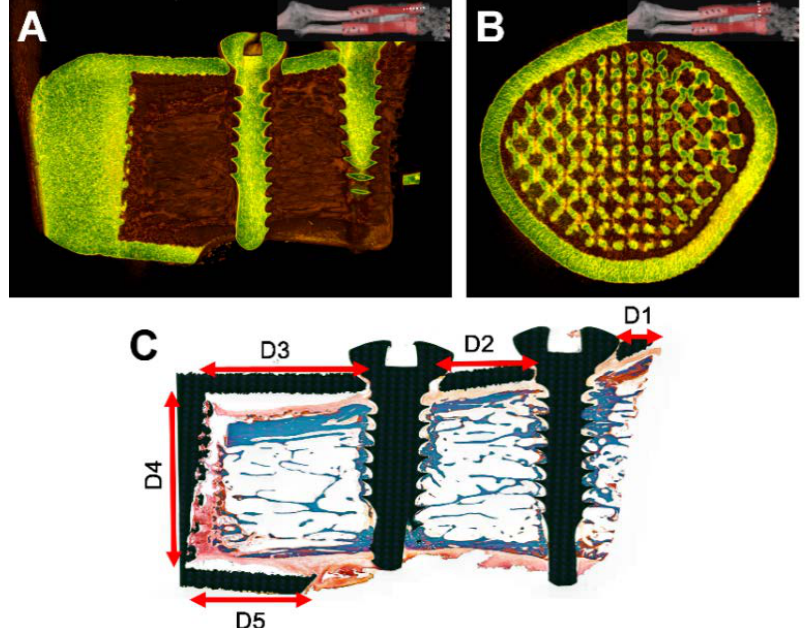
Figure 5. Analyzed segments of the distal region. Micro-computed tomographic images showing ( A ) a longitudinal view and ( B ) axial view, with scout images in the upper right corners. Photomicrograph (( C ): Goldner’s trichrome staining, 1× magnification) of the histological specimen of the longitudinal section showing the analyzed segments (D1–D5).